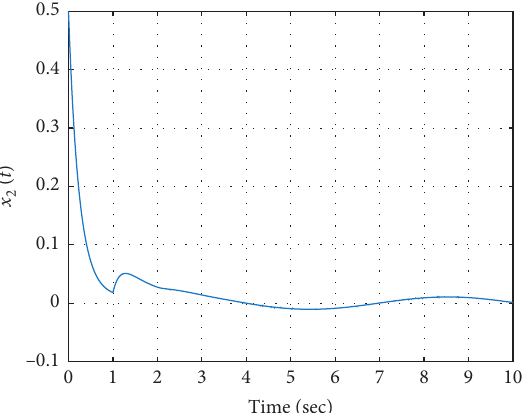
Figure 2: Trajectories of state x ( t ) .